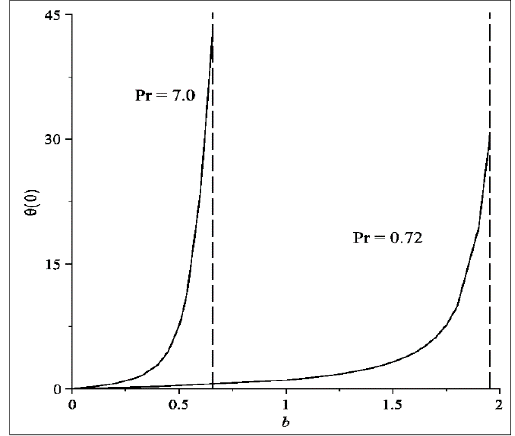
Figure 19. Various values of Pr on surface temperature and b.